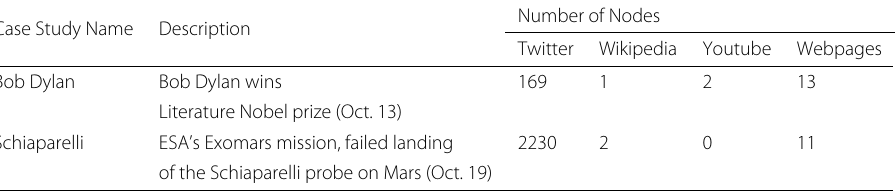
Table 2 Number of nodes of the largest weakly connected components of the case study graphs after